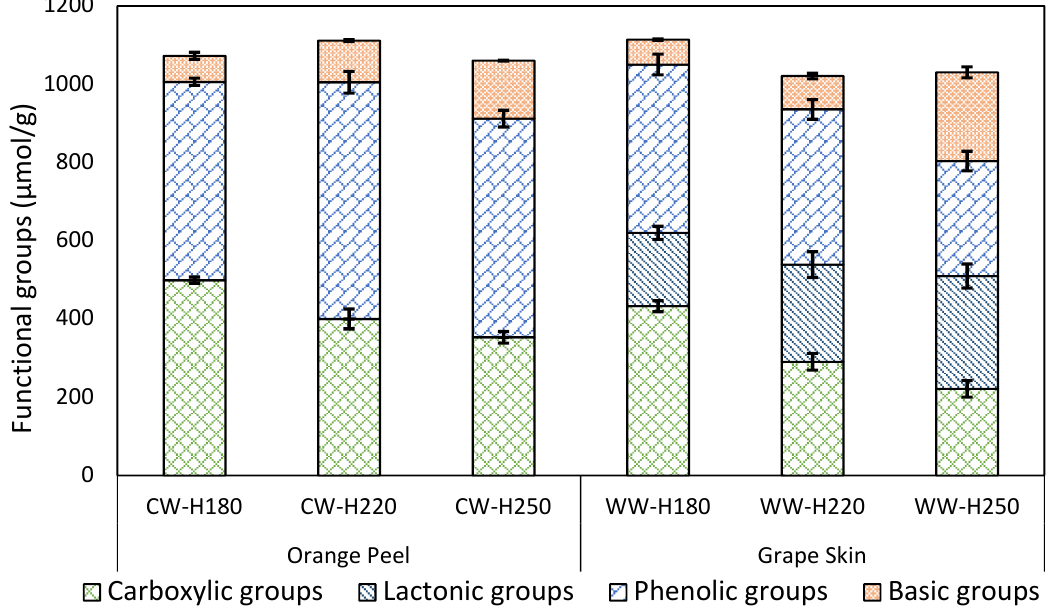
Figure 2. Oxygen-containing functional groups on hydrochars produced from citrus and winery wastes.